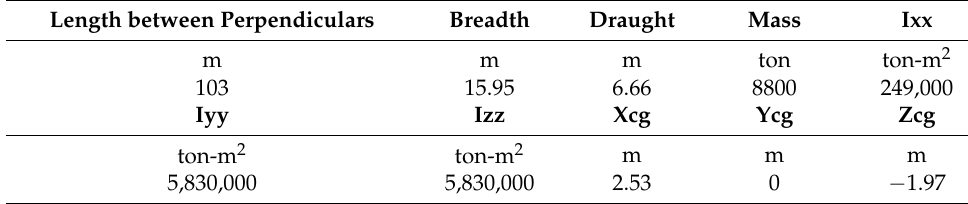
Table 6. Mooring Lines and Riser Coordinates and